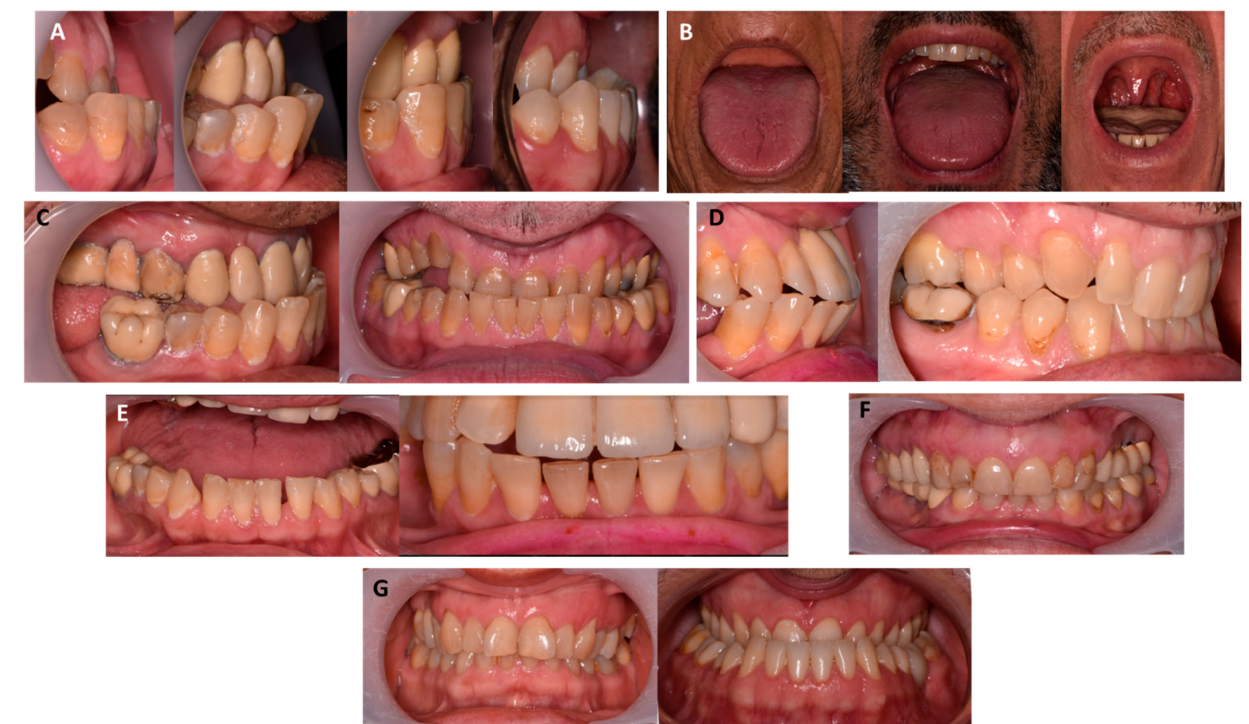
Figure 2. Oro-maxillo-facial features of acromegaly. Panel ( A ) Mandibular growth, prognathism, and class III dental and skeletal pattern; panel ( B ) macroglossia, hypertrophic uvula, and elongation of the soft palate; panel ( C ) dental occlusion; panel ( D ) inclined frontal elements, over-erupted molar teeth; panel ( E ) diastemas; panel ( F ) thickening of the gingival tissues; panel ( G ) palatine and/or mandibular torus and vestibular